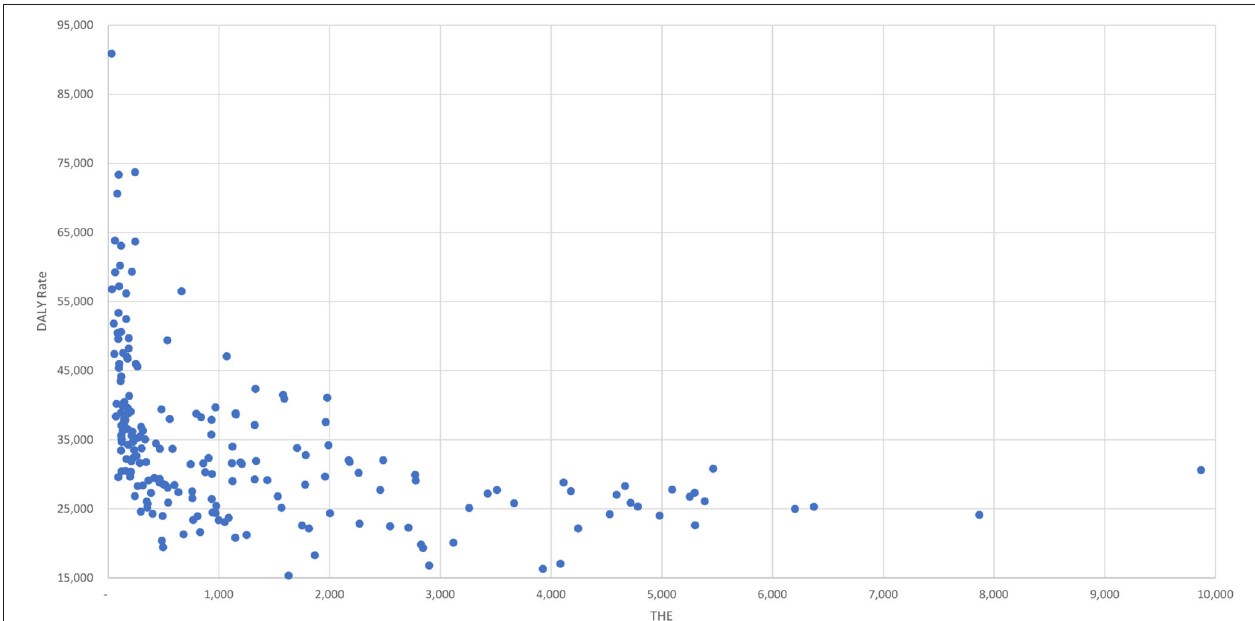
FIGURE 2 | DALY Rate vs. THE for